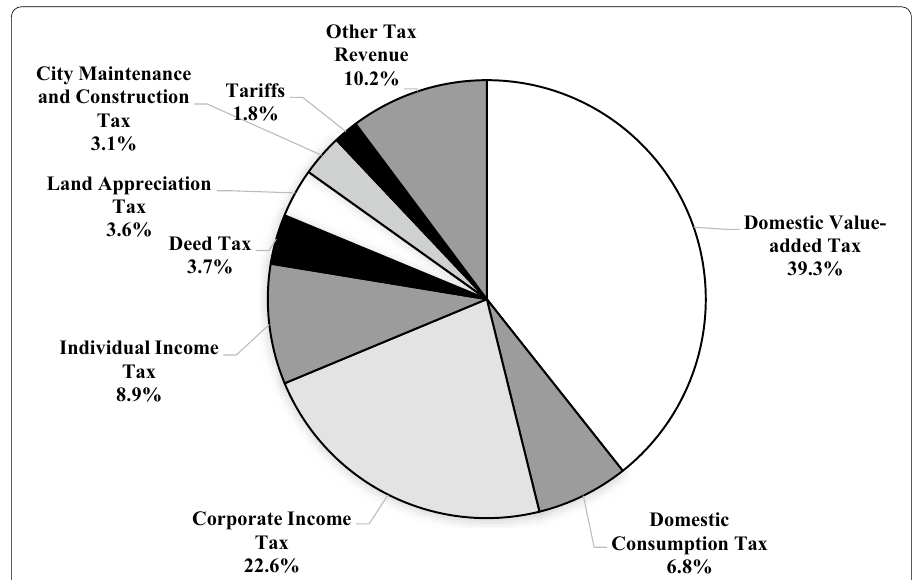
Fig. 4 The proportion of each tax category in the national tax revenue, 2018. Data source: CEInet Statistics